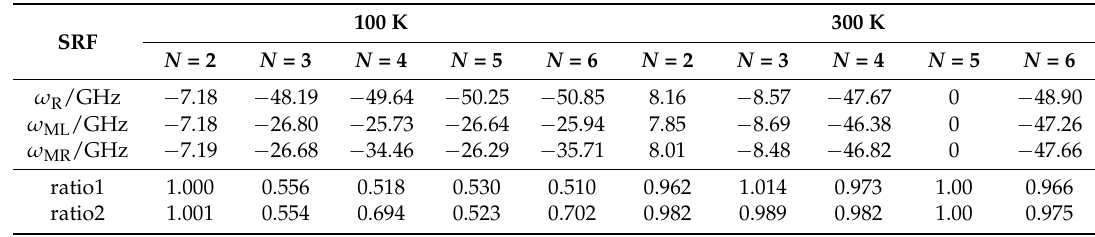
Figure 4. Historical curves of rotational frequencies of the rotor and the related mid-tubes under different conditions. The curves in the left column are obtained at 100 K, those in the middle column are obtained at 300 K, and the data in the right column are obtained at 500 K. The curves in the top row are of the rotor driven by the DNs with N = 2. The bottom row contains the results with respect to N = 6. Table 1. Stable rotational frequency (SRF) of the rotor and the mid tubes at different conditions. The statistics is fulfilled in the last 5 ns of each